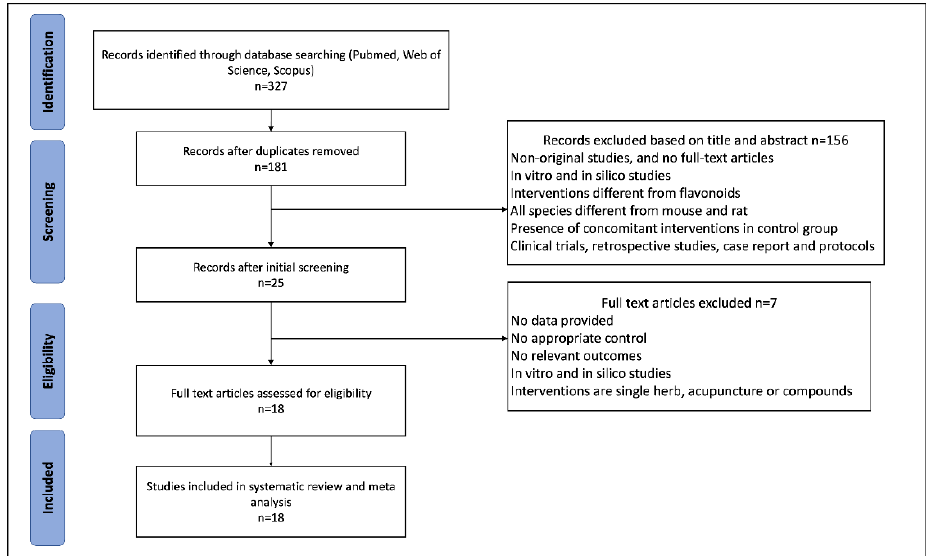
Figure 1. Flowchart of the study selection